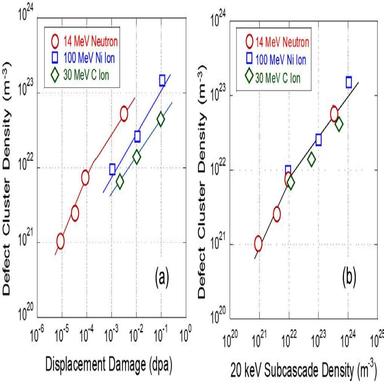
Comparison of the number density of defect clusters produced by irradiations with D-T neutrons and high energy heavy ions in copper (a) as a function of dpa, and (b) as a function of 20 keV subcascade density, estimate based on PKA energy spectra and computer simulation .